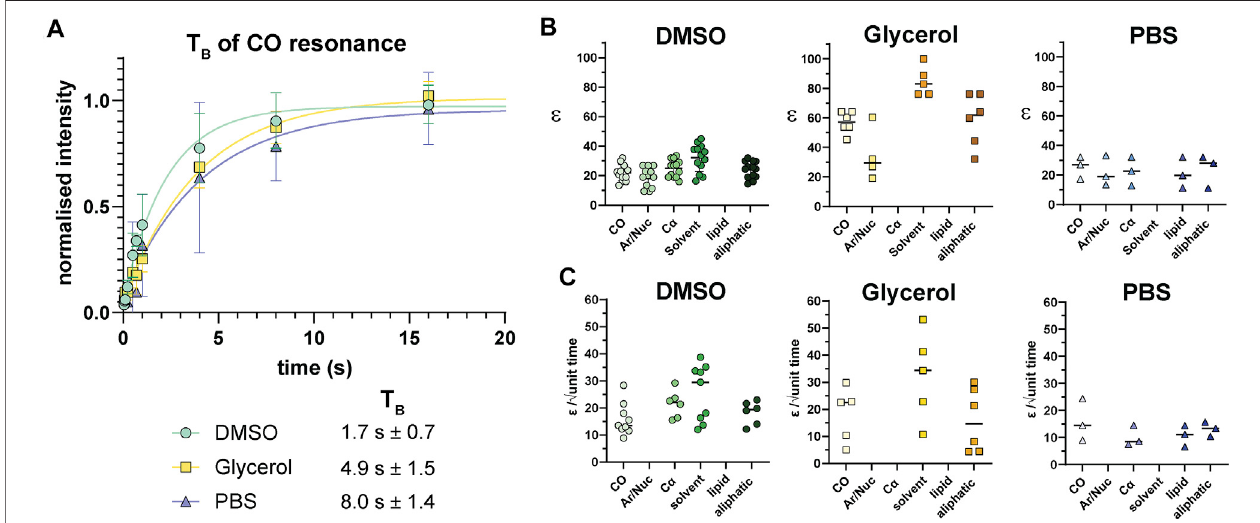
FIGURE2| 13 Cenhancements ofJurkat Tcells. (A) T B buildupcurves for carbonylresonanceswithdifferentcryoprotecting media. Error bars indicate theSD. (B) (cid:2) ε 13 C enhancements (calculated as I on /I off on/off ) in different cryoprotecting media across various cellular components as determined using data from the BMRB. (C) Enhancements calculated per √ unit time using paired data from B and Supplementary Table I . Each symbol represents a single sample. Horizontal bars indicate the mean.